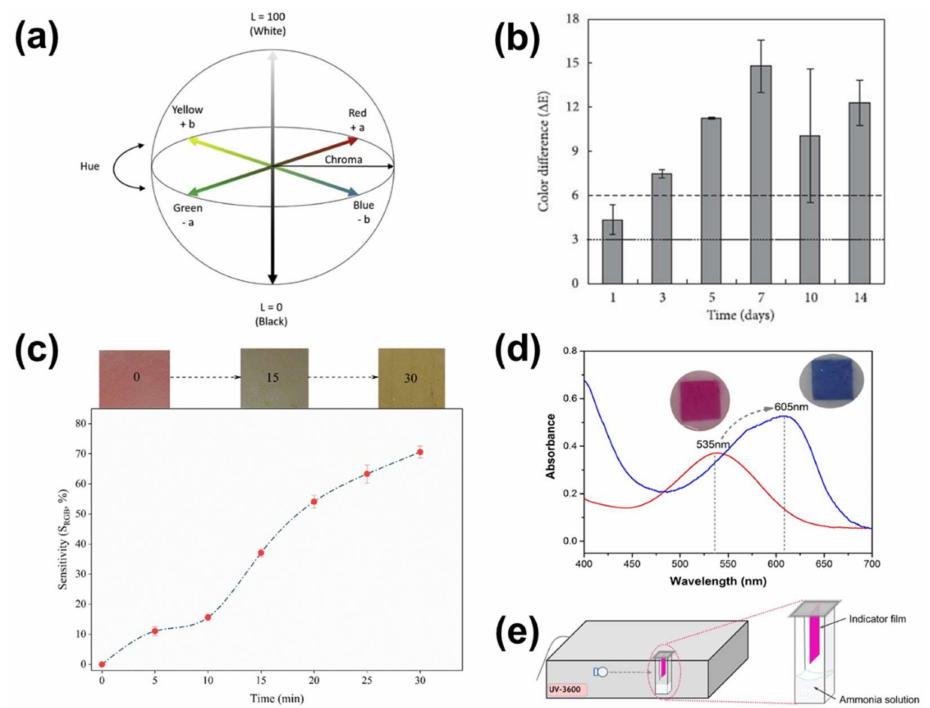
Figure 4. Methods of monitoring of the color change evolution. ( a ) The CIELAB color space analysis. Reproduced with permission from Ref. [177]. ( b ) The color changes of starch-based films along the monitoring of pork spoilage by using the CIELAB color space analysis. Adapted under terms of the CC-BY license [101]. ( c ) The color evolution of an anthocyanin-methylcellulose/chitosan film during its exposure to NH 3 vapors by using the halochromic sensibility S RGB . The photos of the film upon exposure to the vapors for 0 min, 15 min and 30 min are also presented. Reproduced with permission from Ref. [173]. ( d ) The color change of an anthocyanin polymer composite (agarose-purple sweet potato) film monitored by UV-Vis absorption spectroscopy using ( e ) real time monitoring. Inset of ( d ): the photos of the films at the two different states. Reproduced with permission from Ref.